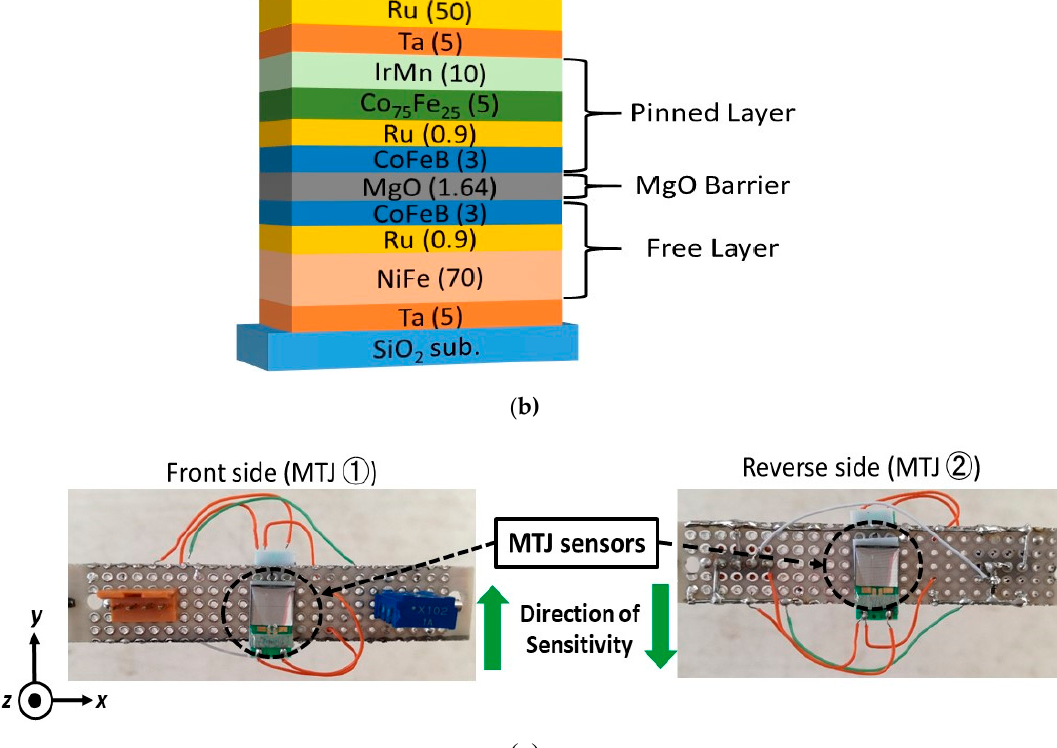
Figure 2. ( a ) The reinforced concrete measurement setup. ( b ) Schematic diagram of the magnetic tunnel junction (MTJ) sensor. ( c ) MTJ sensor setup, the front side sensor (MTJ ① ) is placed right side